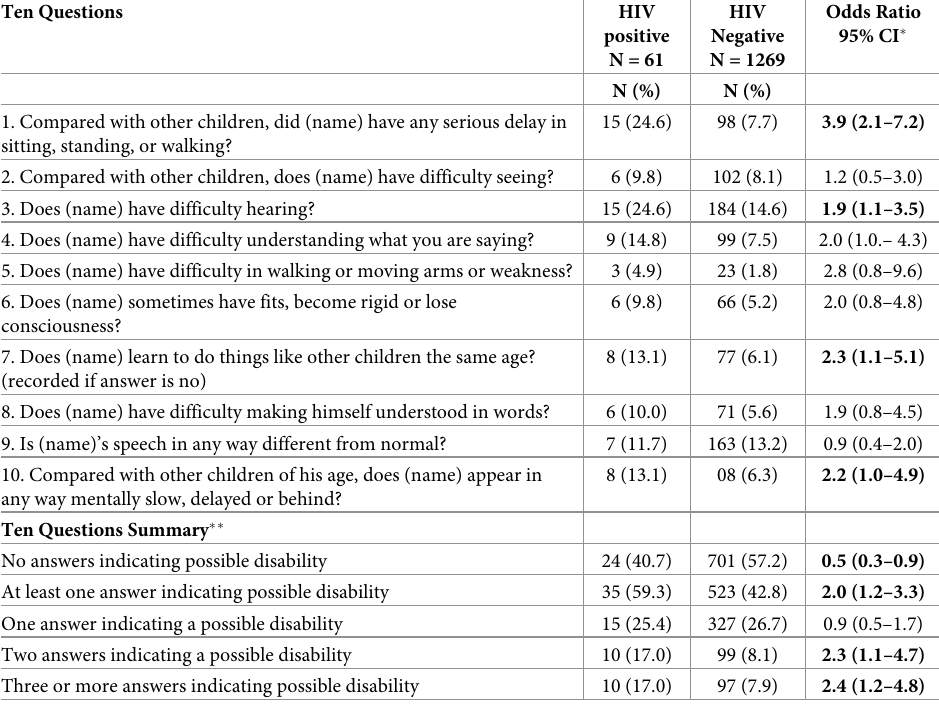
Table 3. TQ screening results: Caregiver’s positive responses regarding the